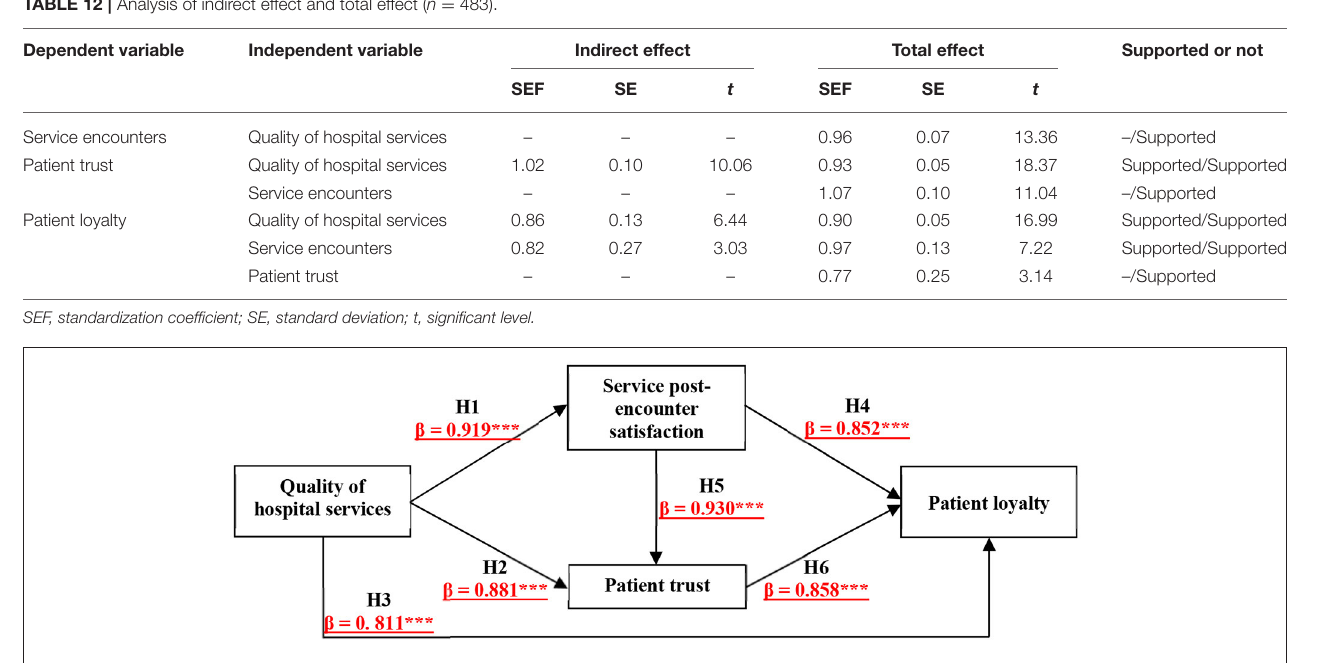
FIGURE 2 | Research model analysis results. The symbol *** indicated the significant coefficients of